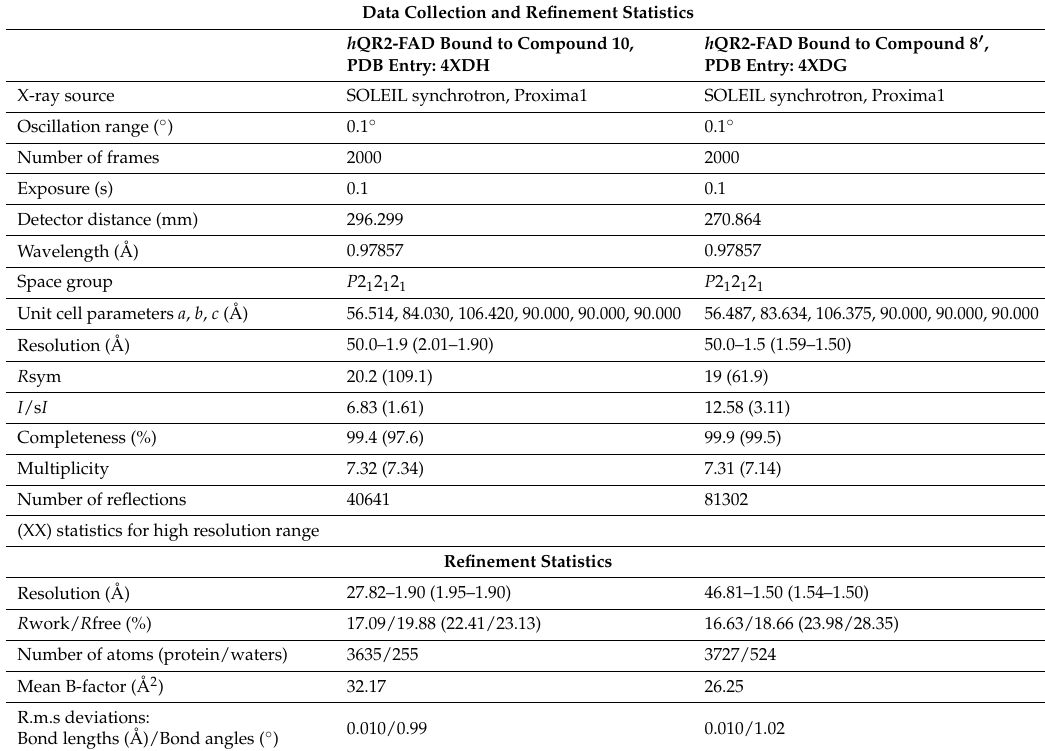
Table 3. Data collection and refinement